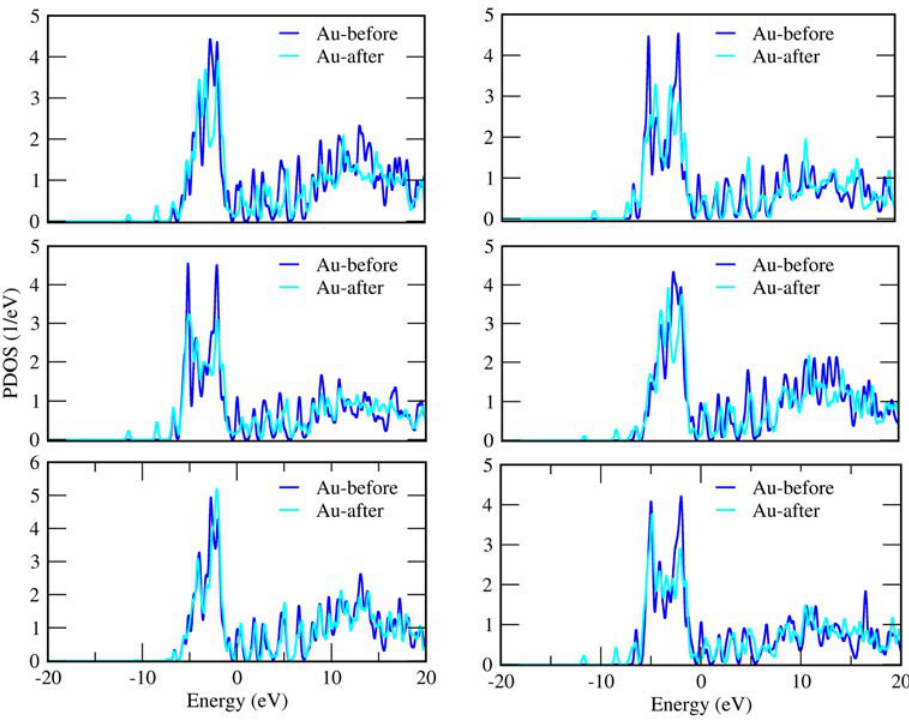
Fig. 10. PDOS for the adsorption complexes of TiO /Gold nanocomposites in before and after the adsorption 2 process, a: A complex; b: A complex; c: B complex; d: B complex; e: C complex; f: C complex.